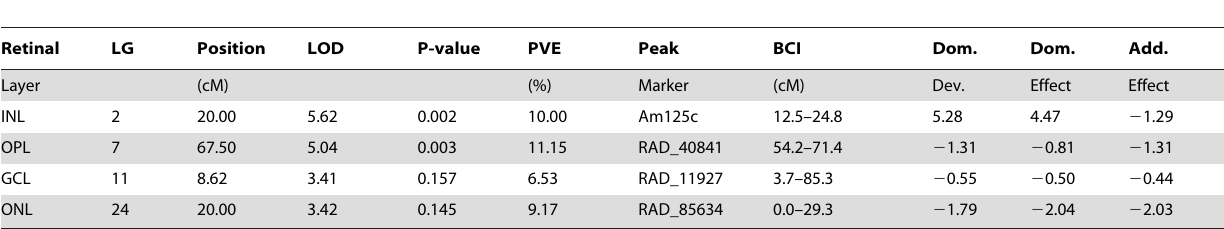
Table 2. Summary statistics of four QTL for Astyanax retinal degeneration.